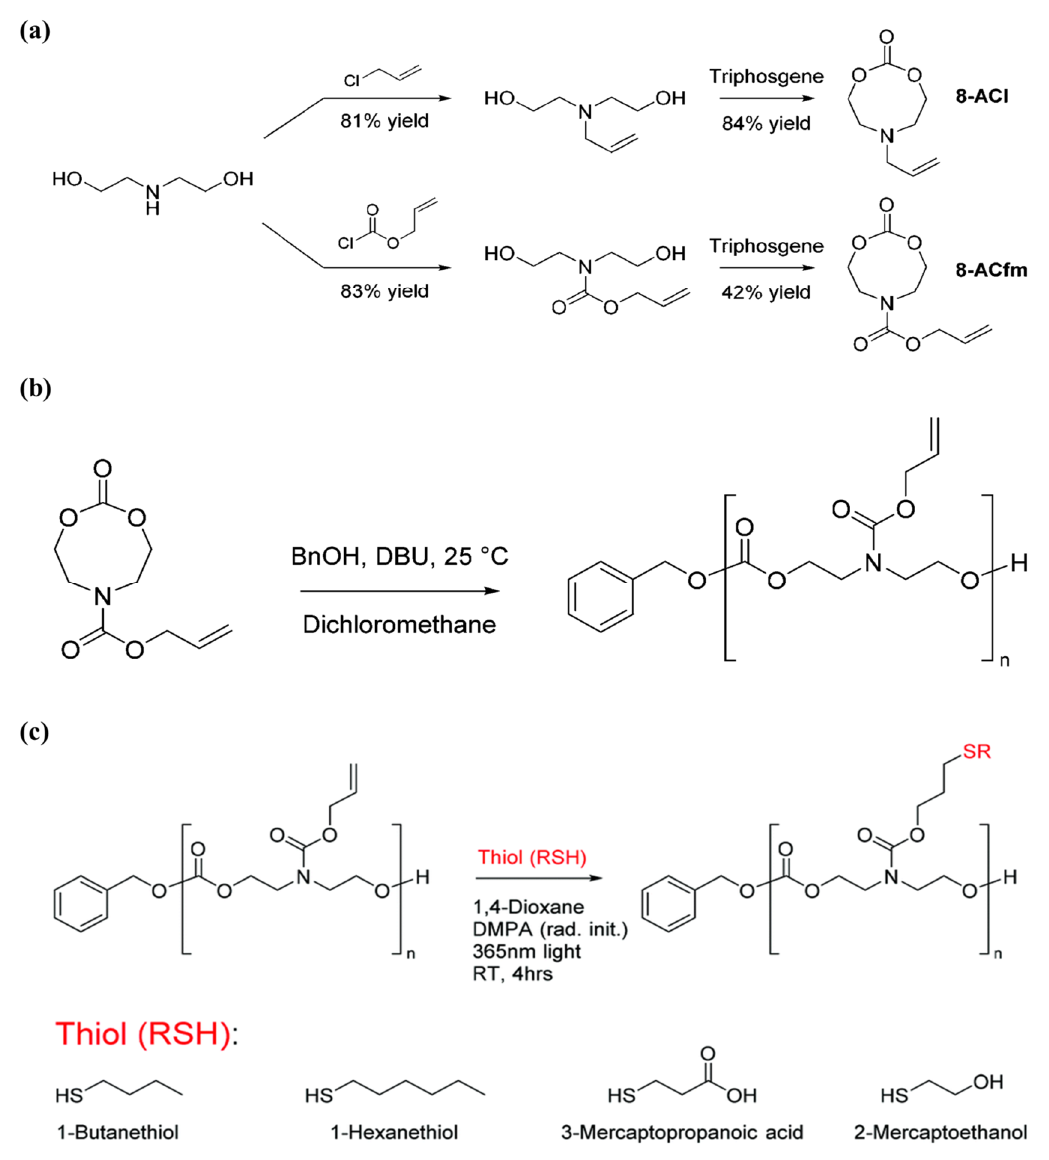
Figure 18. ( a ) Synthesis scheme for allyl bearing eight membered cyclic carbonates, ( b ) ring-opening homopolymerization of 8-ACfm, and ( c ) thiol-ene reaction on 8-ACfm, as proposed by Yuen et al. Adapted with permission from [80]; published by The Royal Society of Chemistry, 2018.